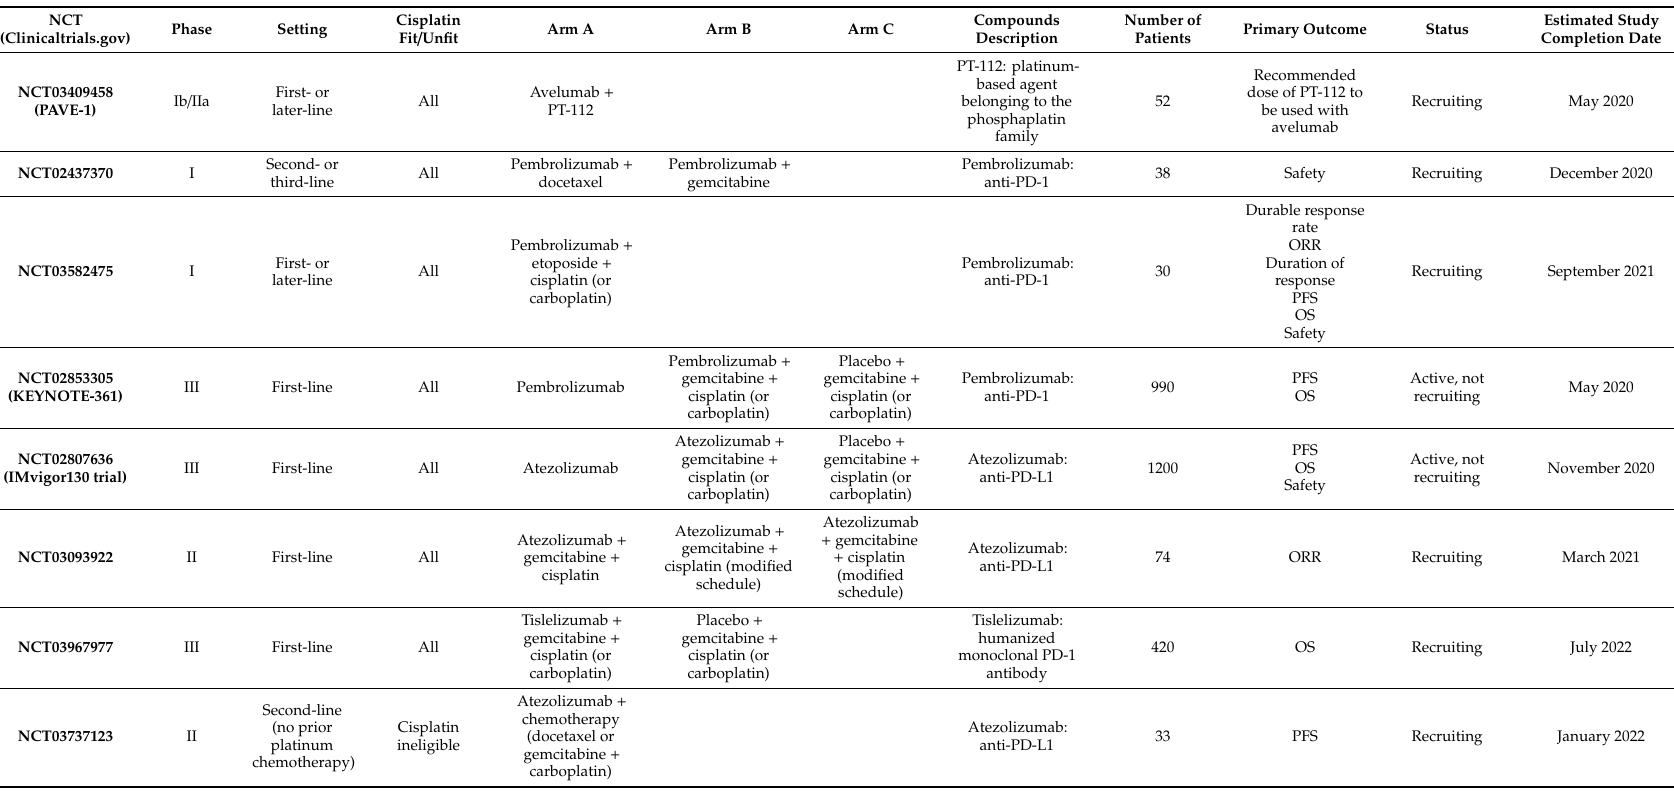
Table 1. Ongoing phase I / II / III trials of immune checkpoint inhibitors in combination with cytotoxic chemotherapy. ORR: overall response rate. PFS: progression-free survival. OS: overall